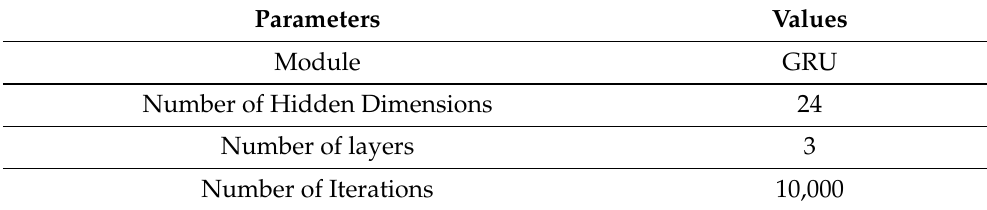
Table 5. Parameter configuration.